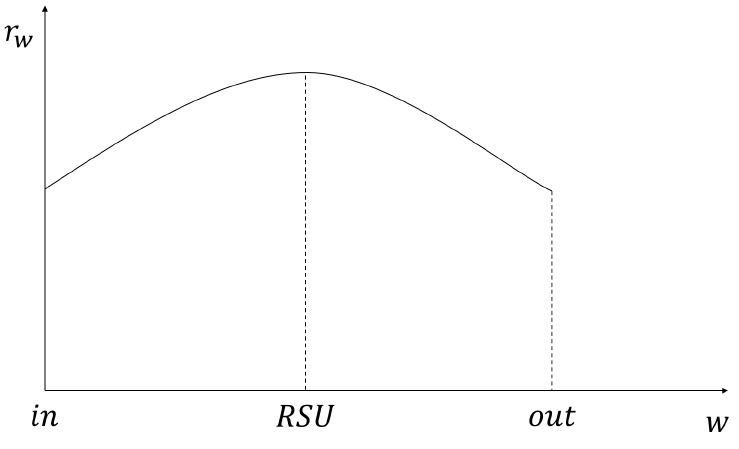
Figure 2. The value of r w within the coverage of an